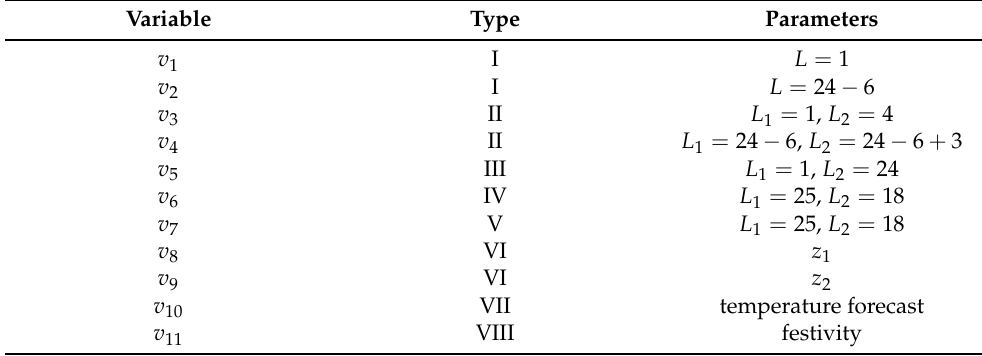
Table 3. Variables considered for the input vector.